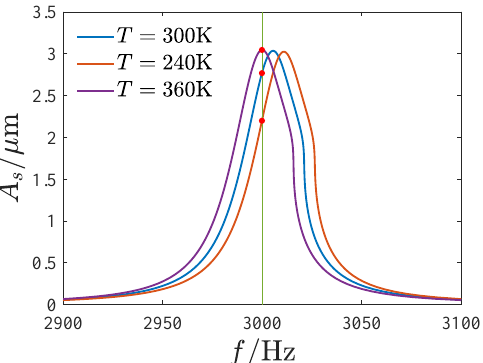
Figure 22. The response curves in sensing direction gyroscope corresponding to different environ- mental temperatures.